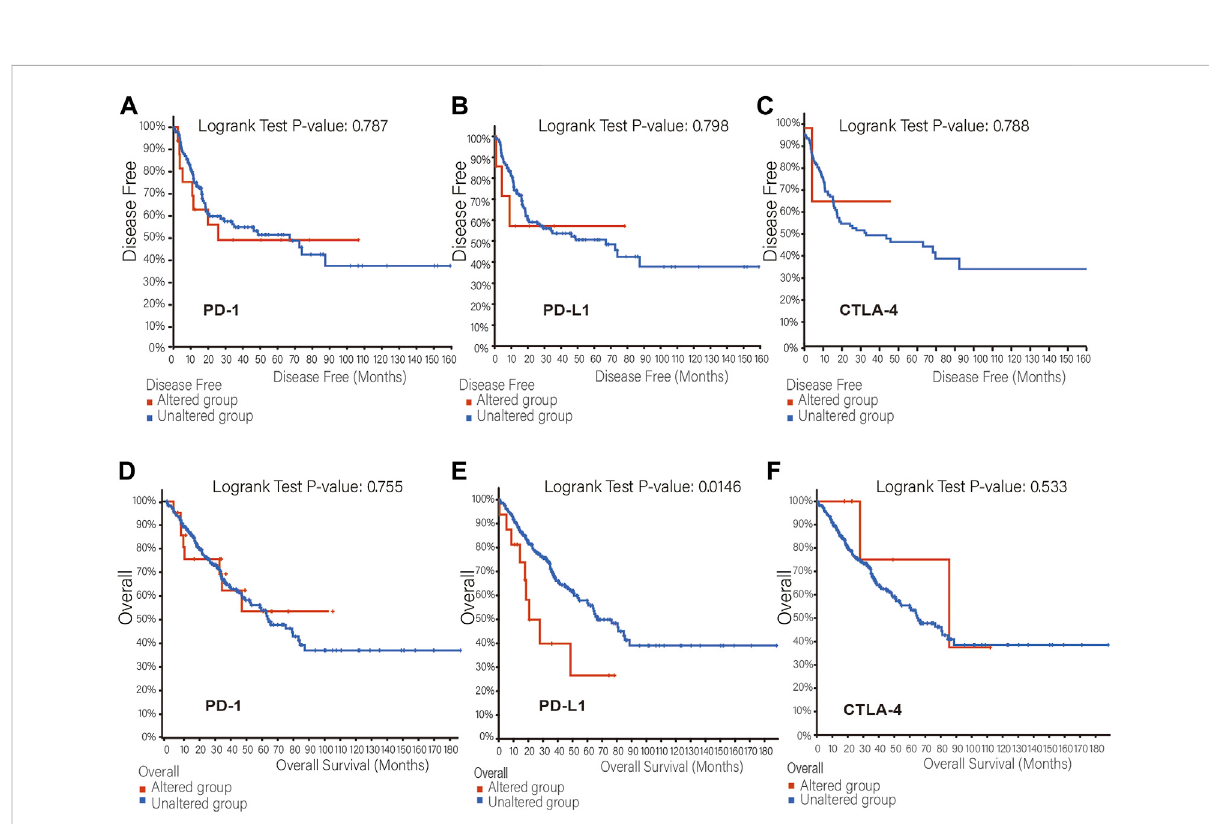
FIGURE 3 The relationship between mutation frequency and survival. (A,B,C) Disease-free survival Kaplan-Meier was performed in cases with or without PD-1 (A) ,PD-L1 (B) ,CTLA-4 (C) alterations. (D,E,F) OverallsurvivalKaplan-MeierwasperformedincaseswithorwithoutPD-1 (D) ,PD-L1 (E) ,CTLA-4 (F)